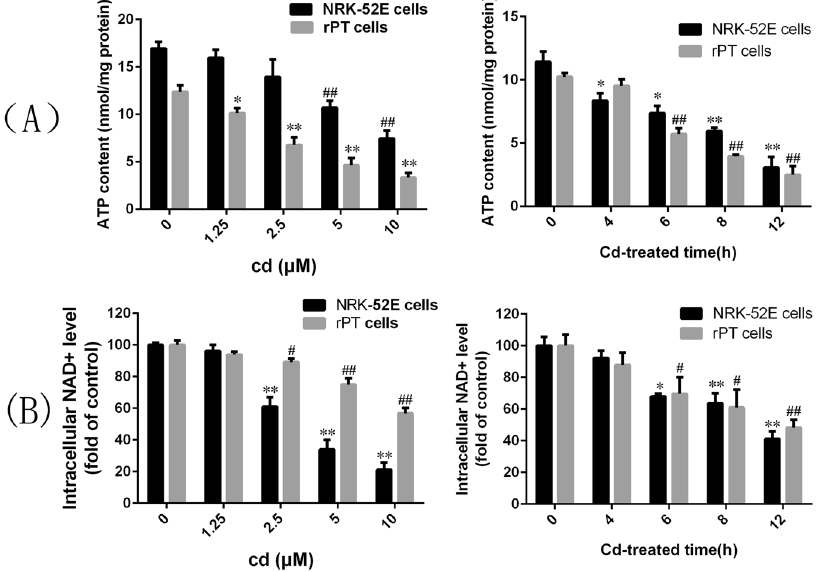
Figure 4. Effects of cadmium on ATP and NAD + contents in NRK-52E and primary rPT cells. ( A ) Effects of cadmium on the ATP content in NRK-52E and primary rPT cells. With the increase of Cd concentration and the prolongation of exposure time the contents of ATP presents decreased trend. ( B ) Effects of cadmium on the NAD + content in NRK-52E and primary rPT cells. With the increase of Cd concentration and the prolongation of exposure time the contents of NAD + presents decreased trend. Data are expressed as mean ± SD (n = 3). * P < 0.05; ** P < 0.01; # P < 0.05; ## P < 0.01 vs. the control group by one-way